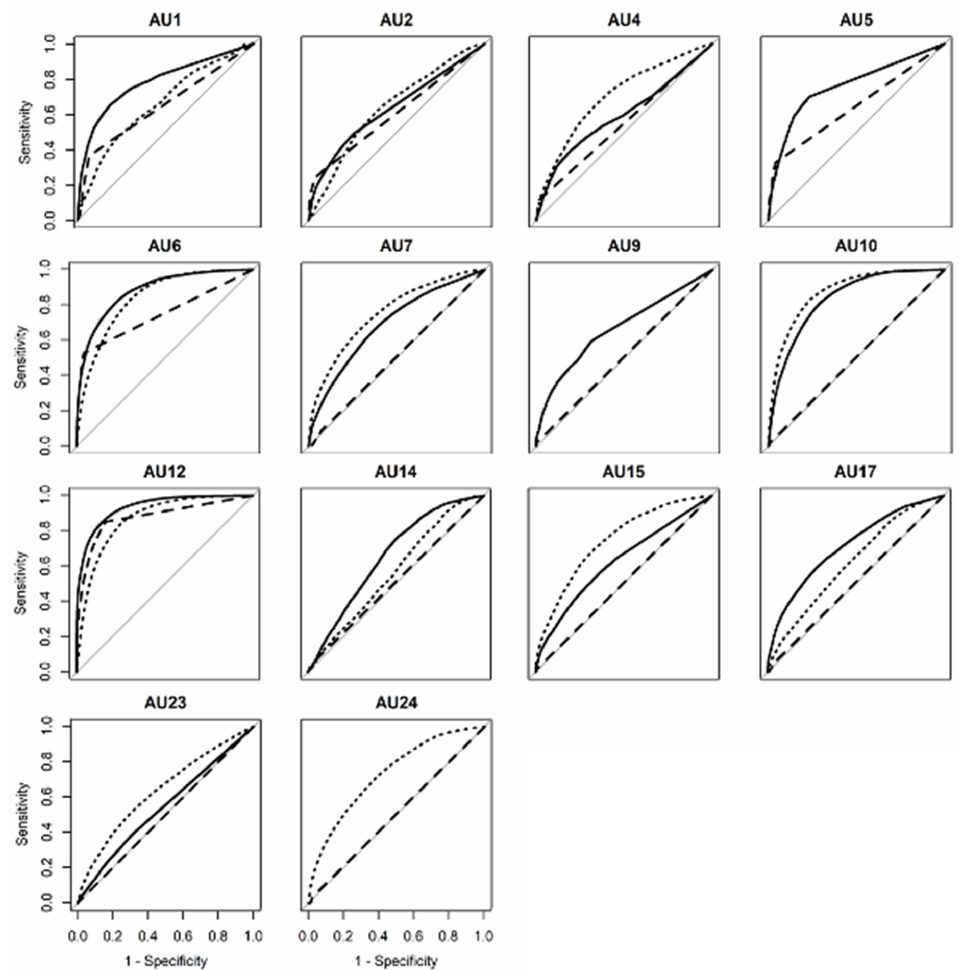
Figure 5. Receiver operating characteristic curves for each action unit in the GFT (conversational) database obtained by the three machines. Solid line represents OpenFace, dashed line represents FaceReader, and dotted line represents AFAR. The diagonal line indicates random performance.